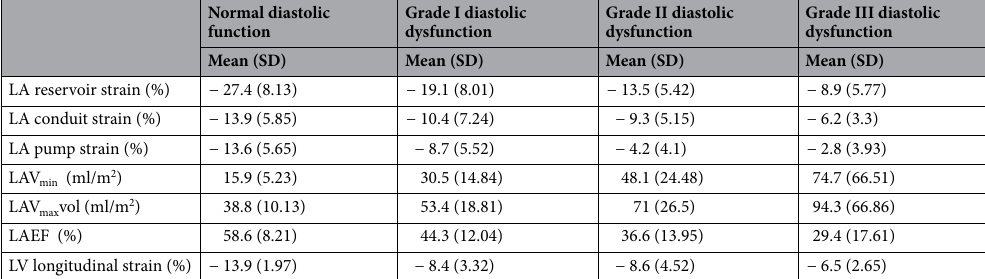
Table 2. Distribution of left atrial strains and volumes across diastolic dysfunction categories.